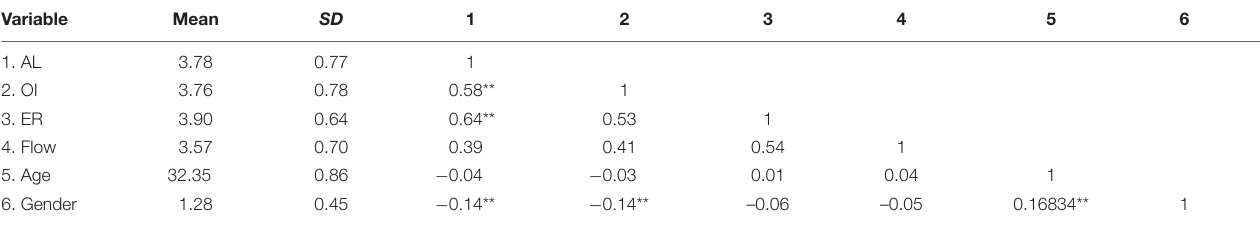
TABLE 1 | Descriptive statistics and correlations.